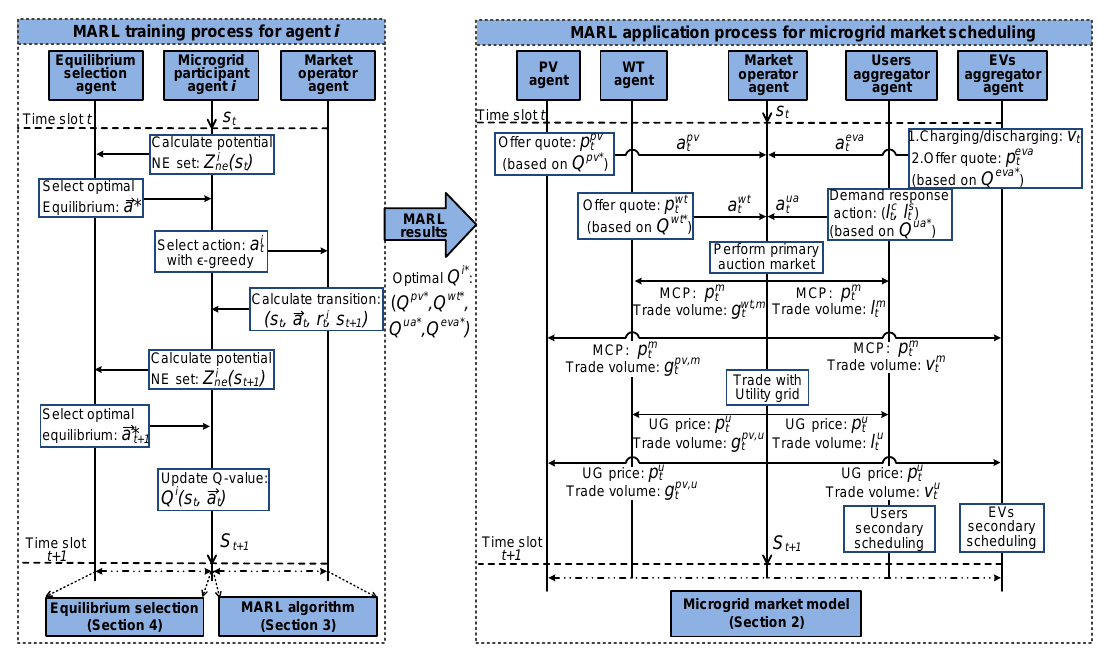
Figure 3. Flowchart of ES-MARL training process and application process for